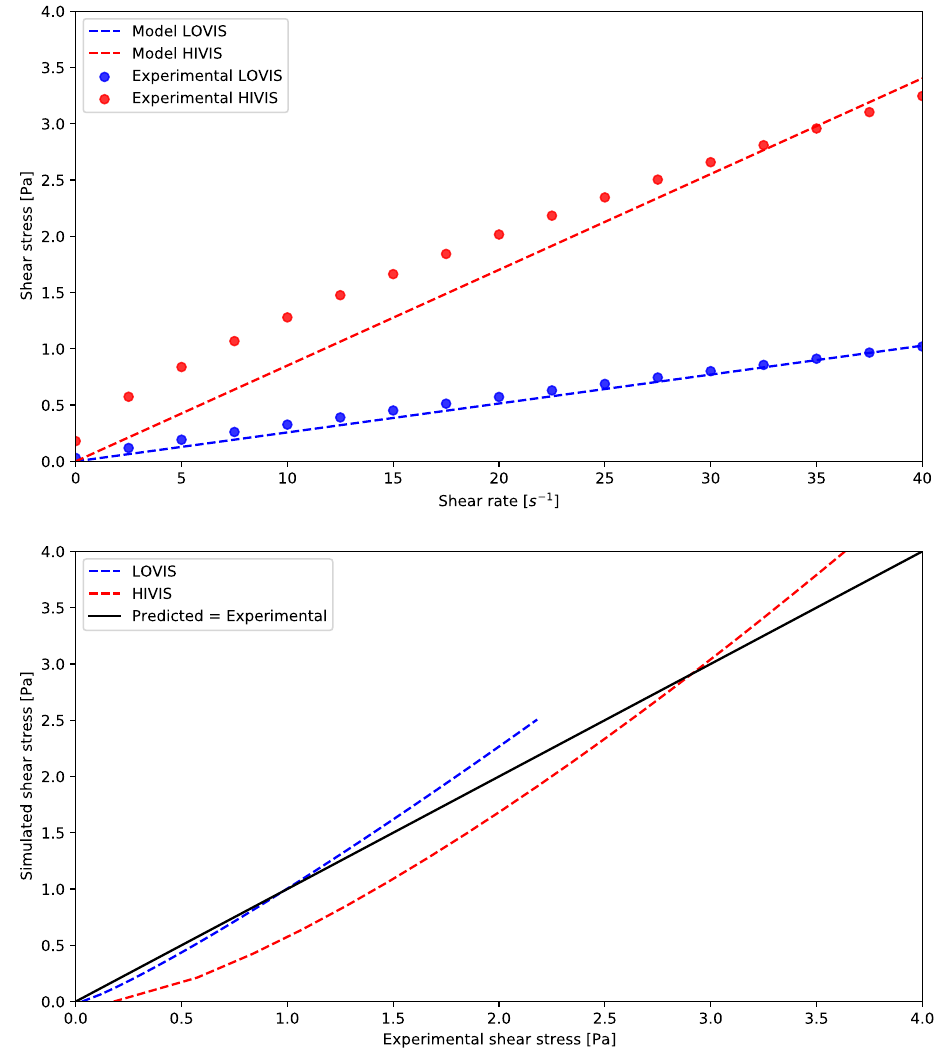
Figure 6. Rheological behaviour of LOVIS and HIVIS fluids in the DCM and the simulated counter- parts in silico. Rheological measurements were carried out at 25 ◦